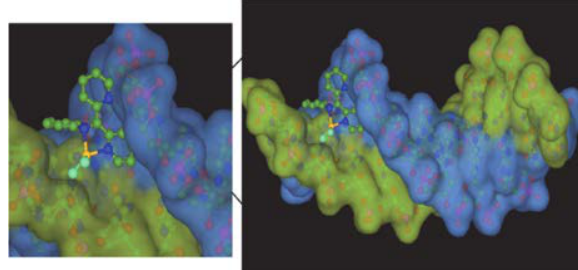
Figure 4. Docked structure of complex I with the HS-DNA duplex of sequence